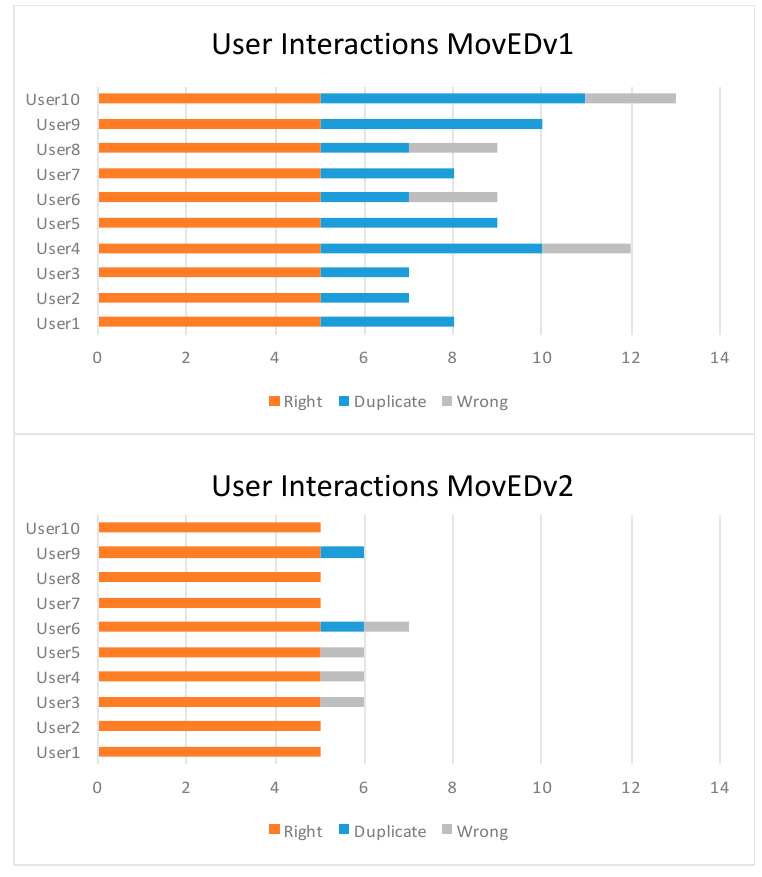
Figure 13. MovED interaction evaluation.